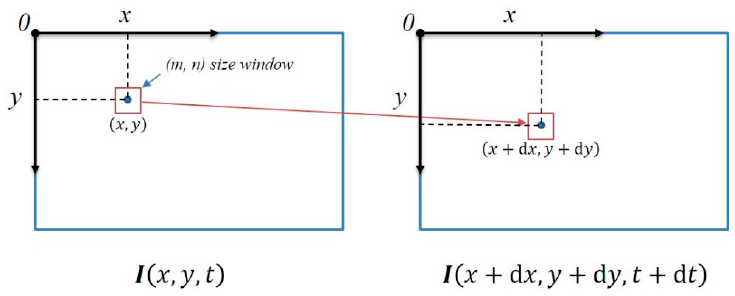
Figure 7. Diagram of the Kanade-Lucas-Tomasi (KLT) feature tracking algorithm.